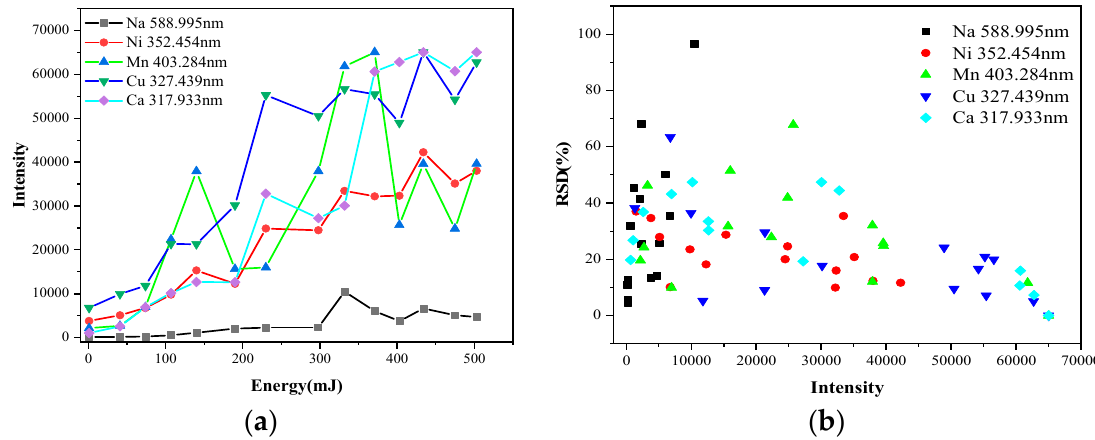
Figure 4. The influence of the pulse laser energy on the measured elements : ( a ) Intensity curves; ( b ) RSD distribution.